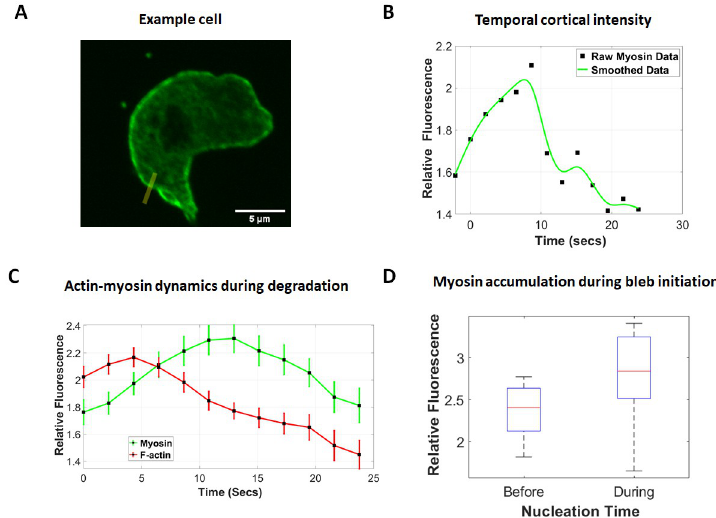
Fig 5. Myosin accumulation in the cortex correlates with cortex degradation. The fluorescence intensity of myosin II (myosin-GFP) and F-Actin (LifeAct-RFP) normalized to the level in the cytoplasm A) along a line through a location where a bleb develops. B) Intensity measurements at the cortex over the bleb development time frame are smoothed using regression splines. C) Time shifted mean myosin and F-Actin intensity for 39 blebs from 19 cells with error bars representing SEM. The point of bleb nucleation is set to time 0. D) Box plot showing the distribution of myosin before and at bleb nucleation. The frame rate is 2.14 seconds. Observed difference in medians is significant (Kruskal-Wallis test: p-value =